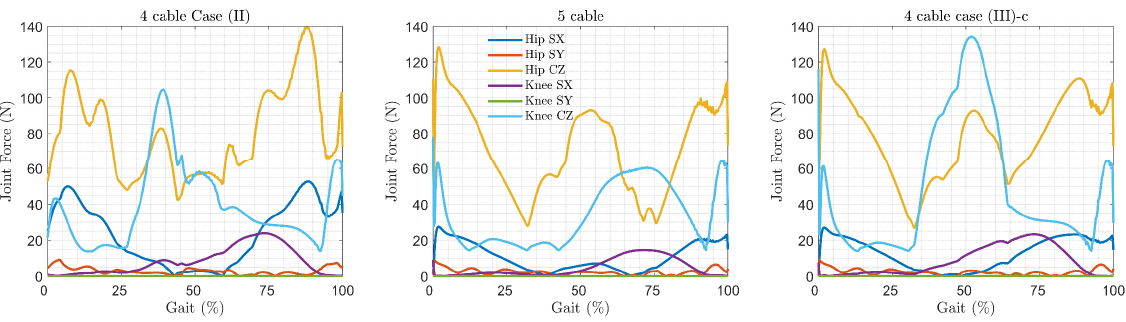
Figure 14. Joint force components induced by the applied cable tensions in each routing (SX and SY